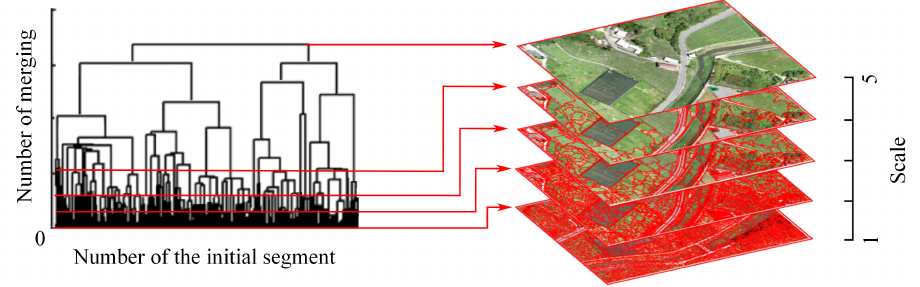
Figure 4. An example of a scale set